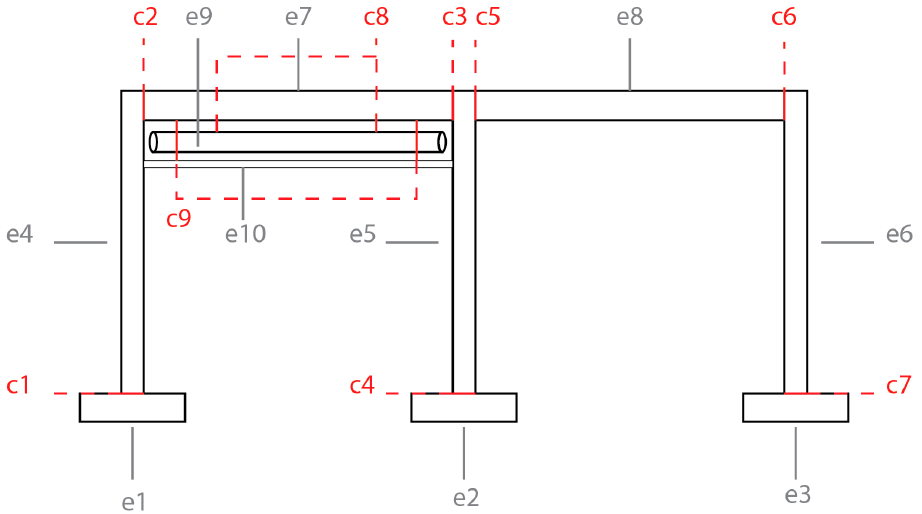
Figure 3. Each element, e#, is attached to another one through a connection, c#. It should be noted that a set of connectors is considered as one connection. Adapted from Sanchez and Haas [16].